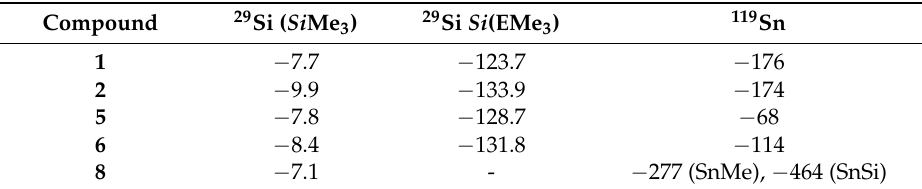
Table 1. NMR spectroscopic characterization of 1 , 2 , 5 , 6 , and 8 .